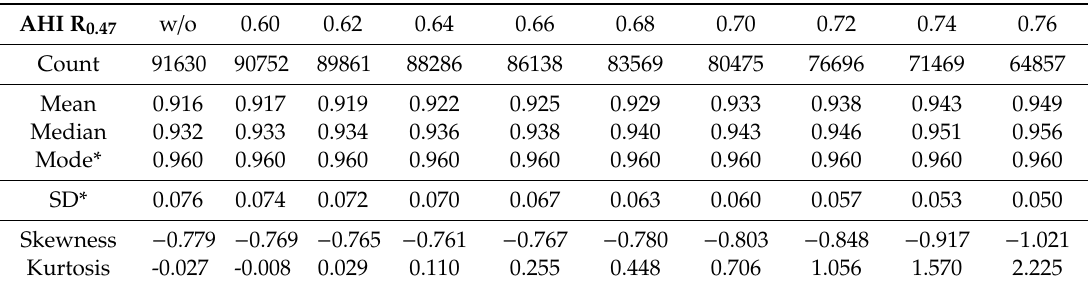
Table 4. Statistics for TROPOMI DCC R 0.354 depending on the addition of an AHI R 0.47 threshold for DCC detection compared to the conventional DCC detection (w / o column) using DCC measurements for July 2018–June 2019 taken at five-day